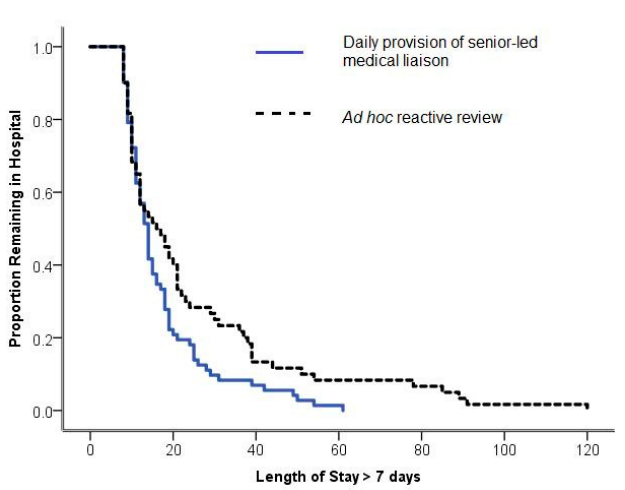
Figure 1. Kaplan-Meier Survival Curve. Reduction in LOS was seen for patients admitted for >7 days ( p = 0.025, 95% CI for mean difference, 1.5 to 14 days).